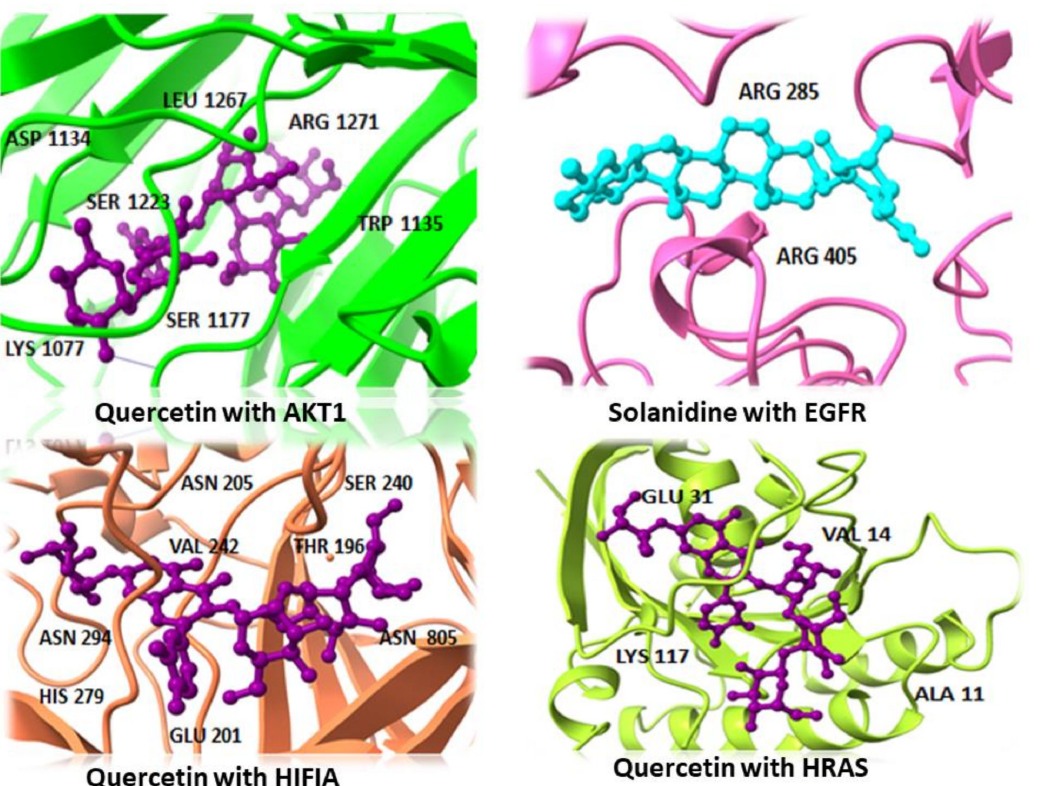
Figure 6. The docked complex of active constituents of S. surattense